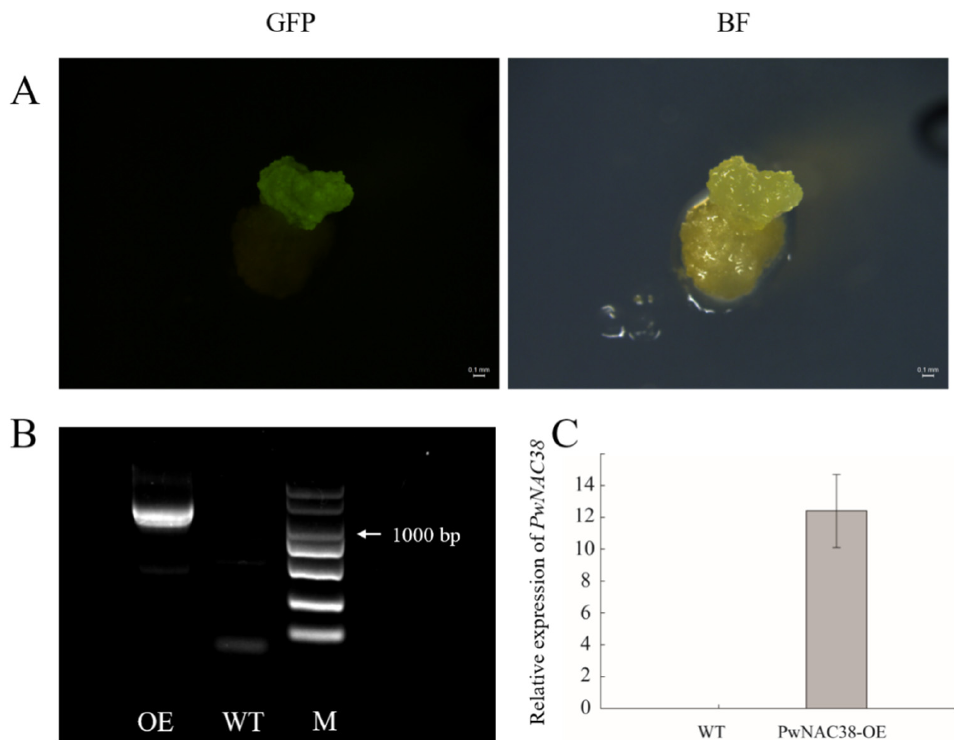
Figure 9. Identification of overexpressing PwNAC38 in apple calli. ( A ) Detection of PwNAC38-GFP fusion protein under GFP channel and Bright field. ( B ) Identification of PwNAC38 in transgenic apple calli. ( C ) Relative expression of PwNAC38 in transgenic apple calli.